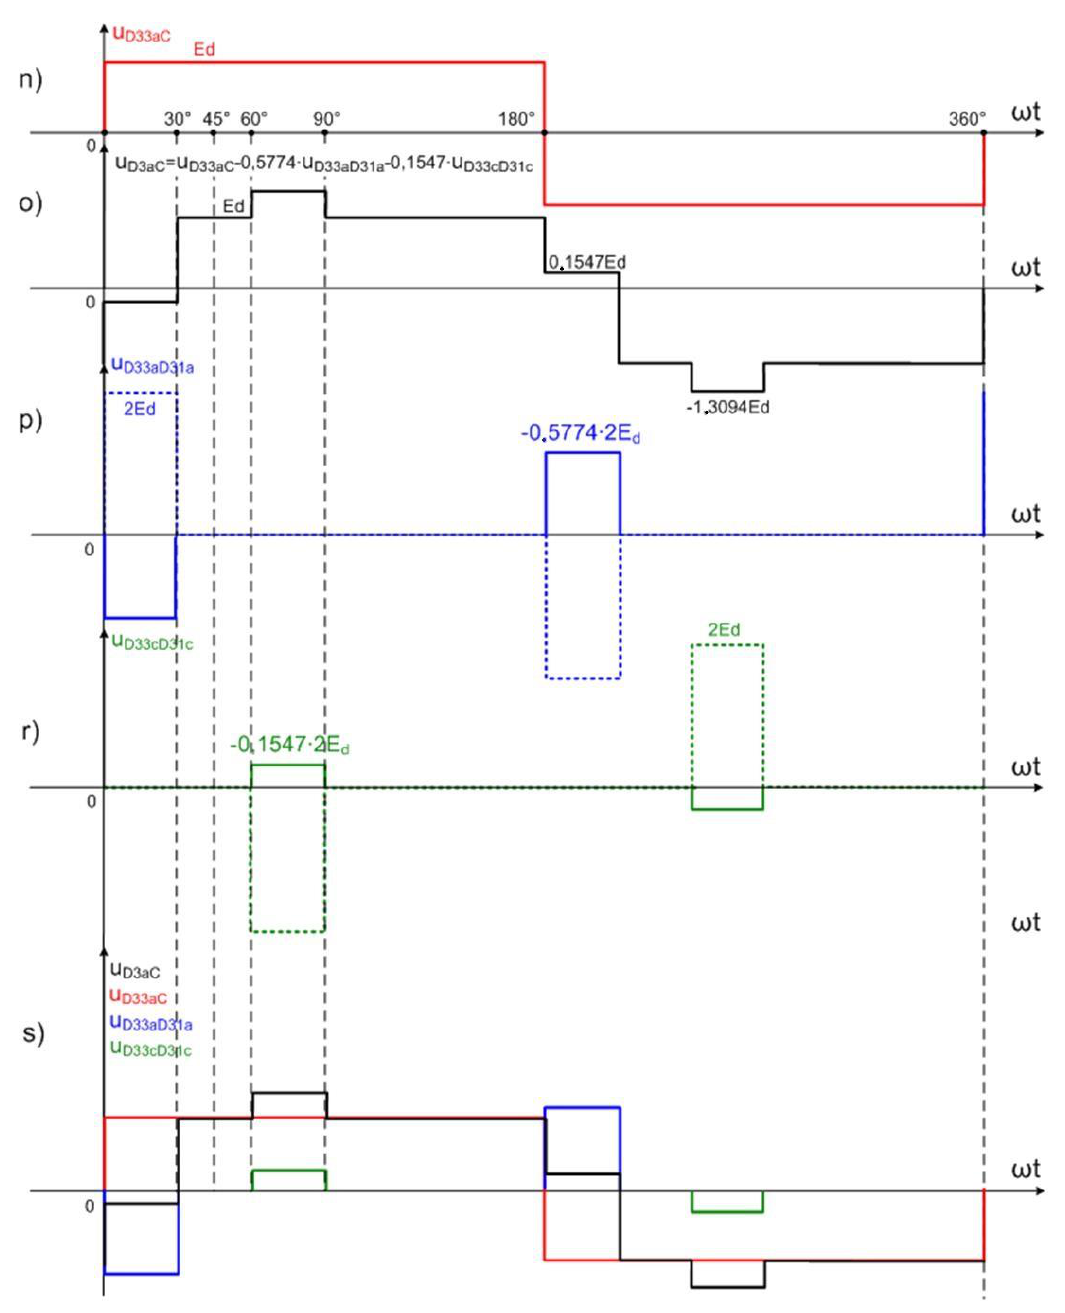
Figure 16. Design of the voltage waveform u D 3 aC , u D 1 aC